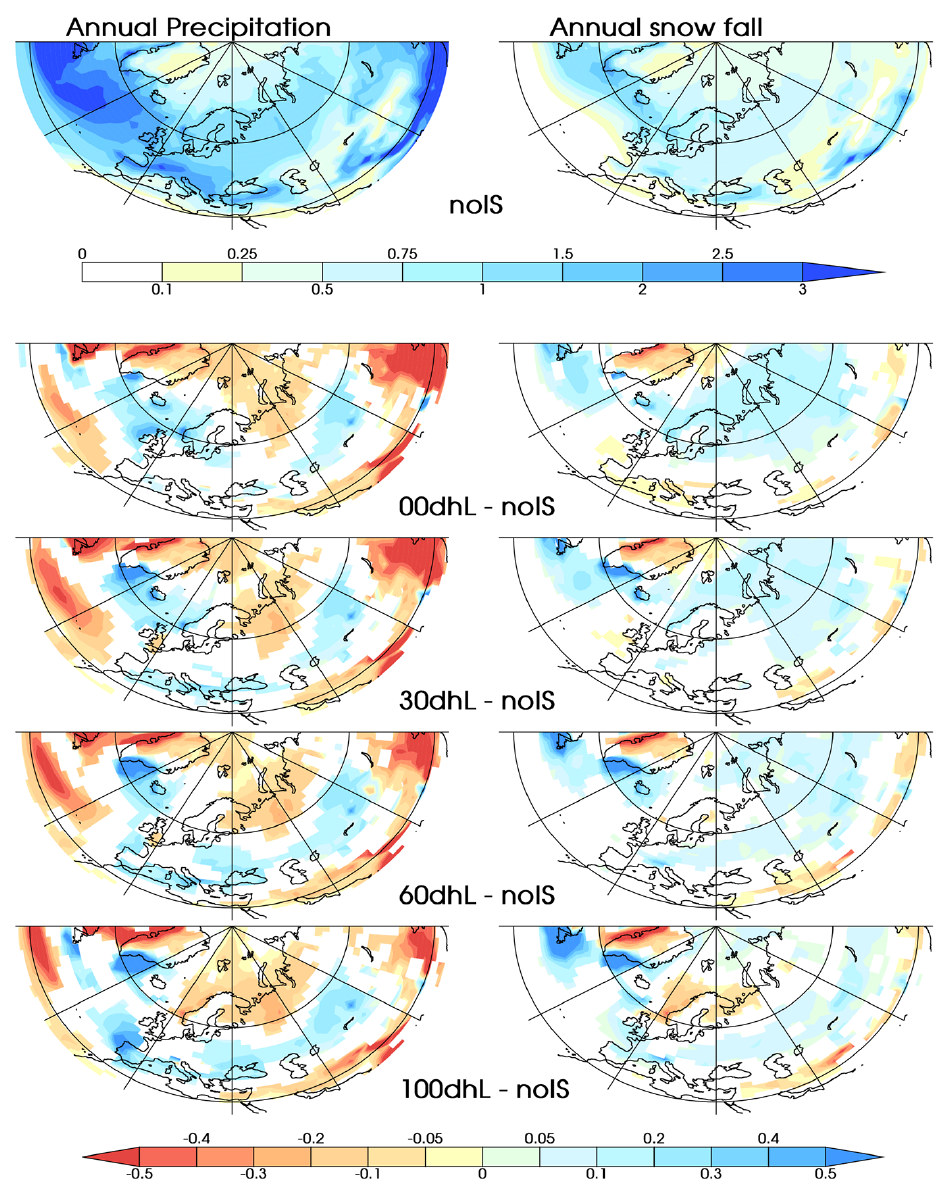
Figure 6. Same as Fig. 3 for annual precipitation (left column) and annual snowfall (right